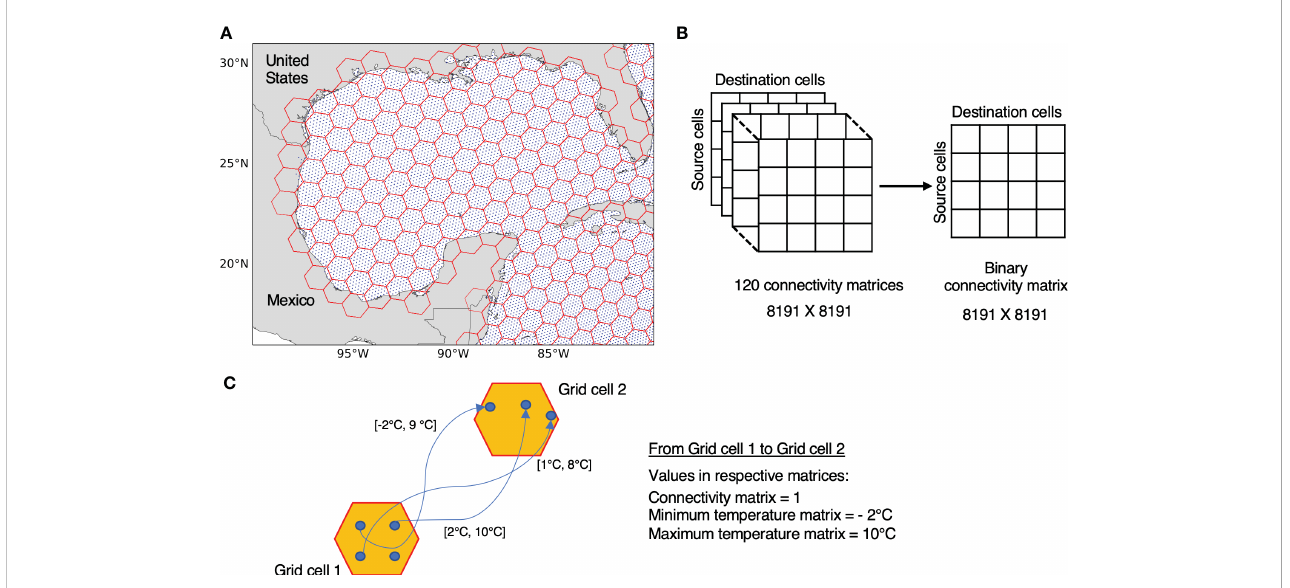
FIGURE 2 (A) Particles release and gridding shown for the Gulf of Mexico region: Particles release locations (in blue ) are mapped to hexagonal cells (in red ) using resolution 3 of H3 indexing system. (B) Presence or absence of connectivity between 8191 resolution 3 H3 grid cells across the release domain from 120 simulations are stored in a single binary matrix. (C) Extraction of resultant connectivity and minimum/maximum temperatures from multiple 30 days long trajectories connecting two grid cells. Values in square brackets represent the minimum and maximum temperature observed in a given particle